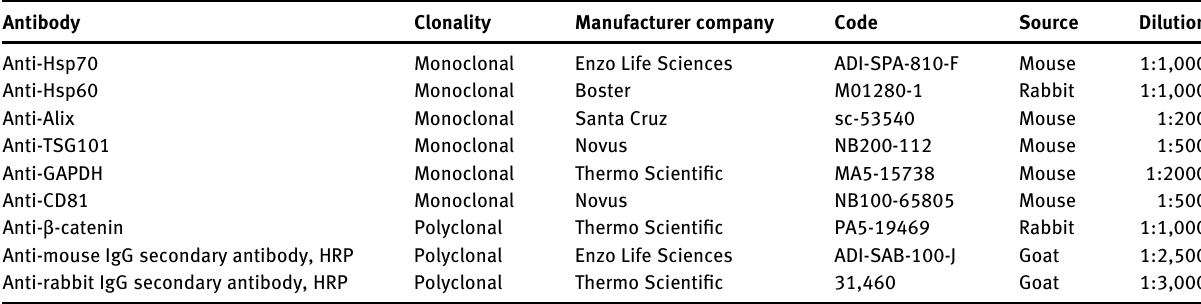
Table  : Primary and Secondary antibodies were used in the immunological analysis.